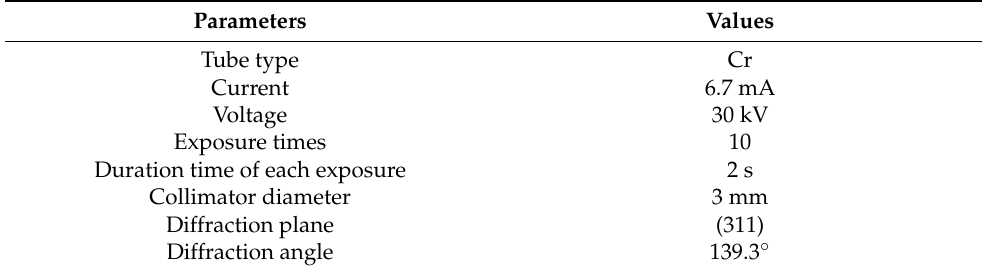
Table 2. Parameters of X-ray